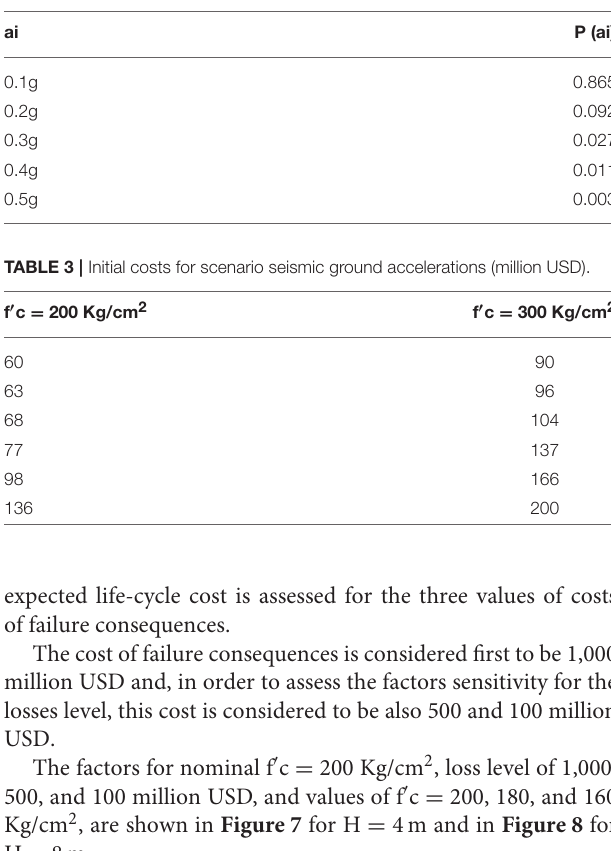
FIGURE 7 | Compensation factors for several actual values of f ′ c, several losses levels, H = 4m and nominal f ′ c = 420 Kg/cm 2 , Ciudad de México.